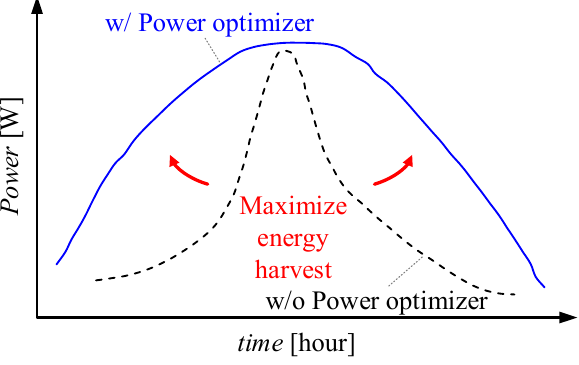
Figure 13. Maximizing the energy harvest using a power